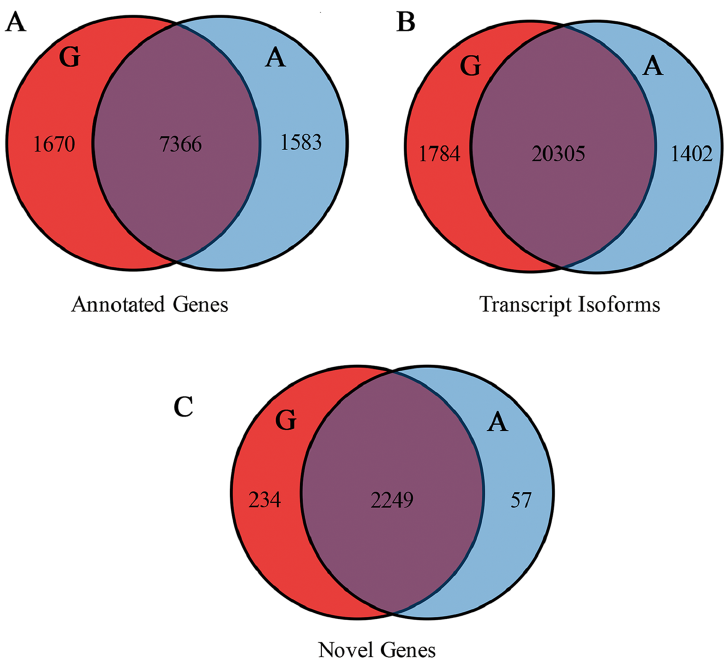
Fig 3. Venn diagram of global annotated genes, transcript isoforms and novel genes expressedin Gushi chickens and AA chickens by Ribo-Zero RNA sequencing. Venn diagramsshow the distributionof annotated genes (A), transcript isoforms (B), and novel genes (C) detected in Gushi chickens and AA broilers. Red indicatesGushi chickens, and blue indicatesAA chickens.